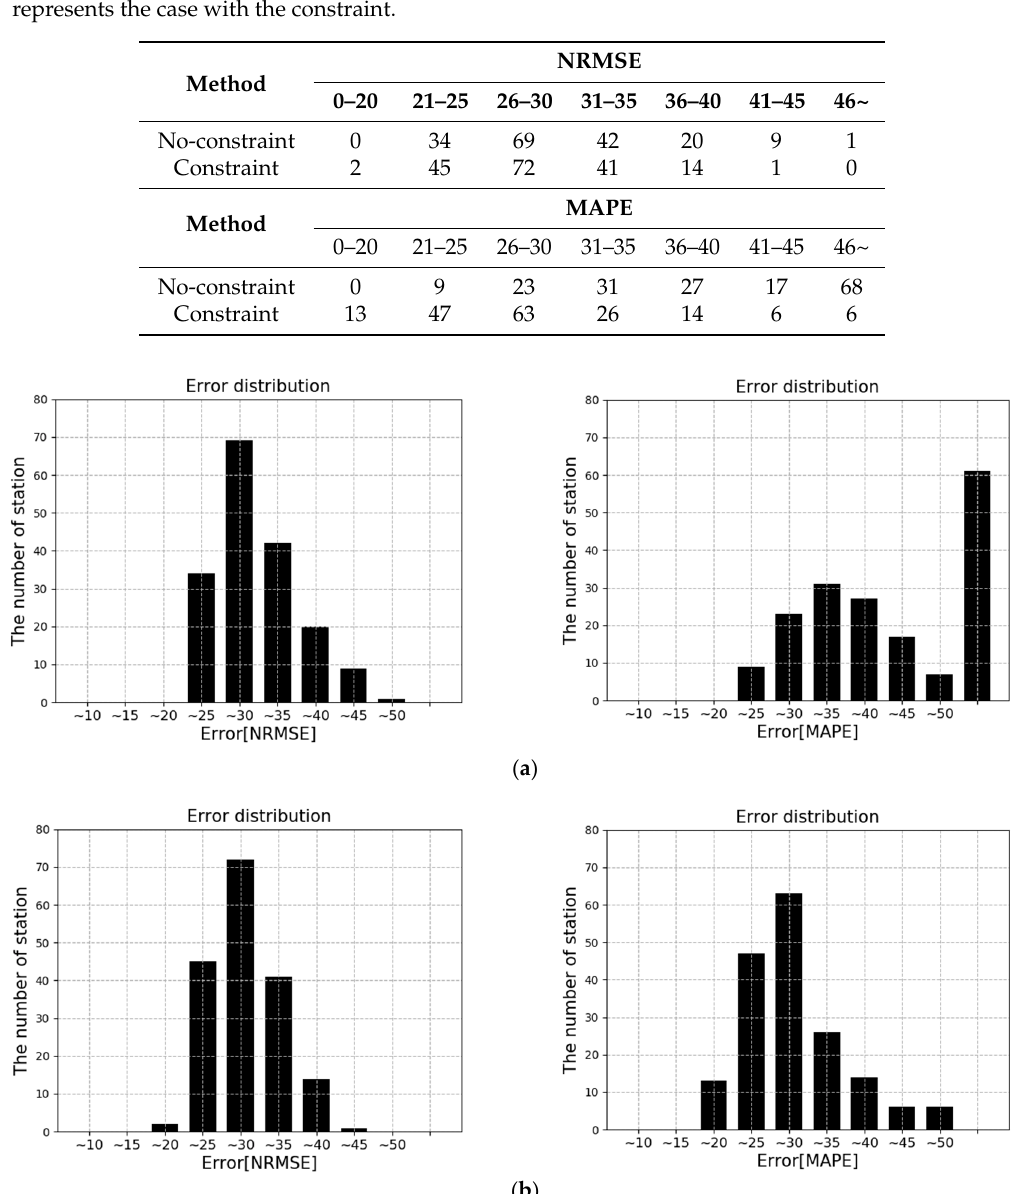
Table 3. The distributions of estimation errors of stations with and without minimum electricity consumption constraint. ‘No-constraints’ represents the case without the constraints and ‘Constraint’ represents the case with the constraint.